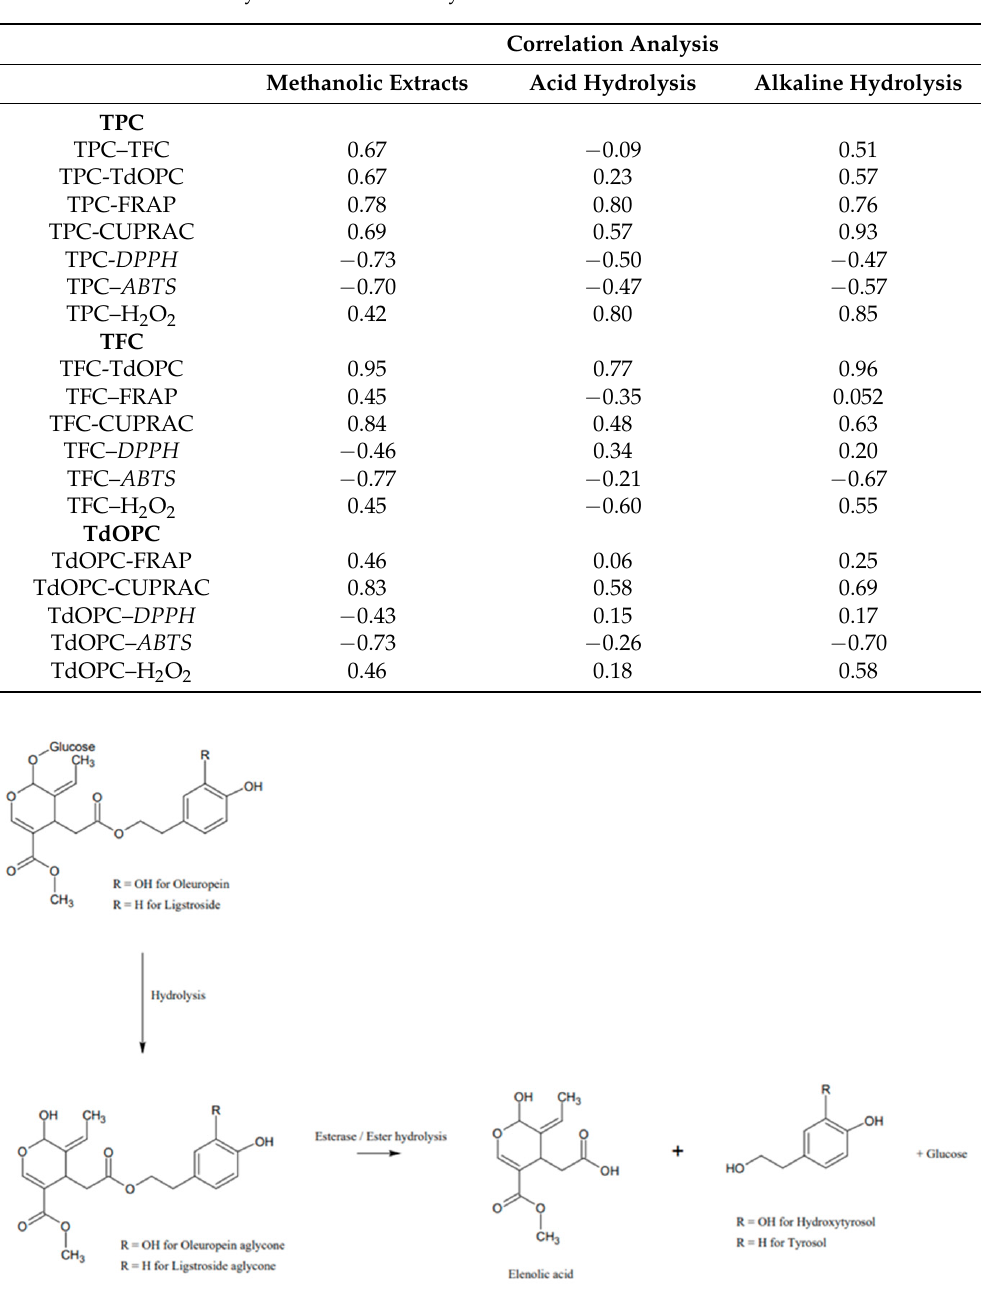
Figure 13. A figure shown by Johnson et al. [57], showing the structures of oleuropein, ligstroside and other related hydrolysis products.